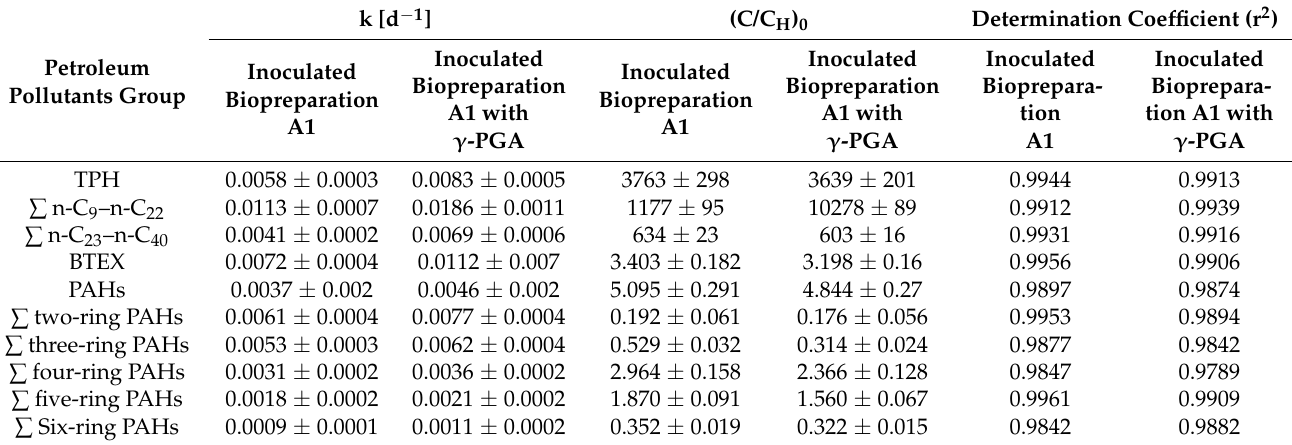
Table 4. Coefficients of first-order mathematical model describing TPH, BTEX and PAHs